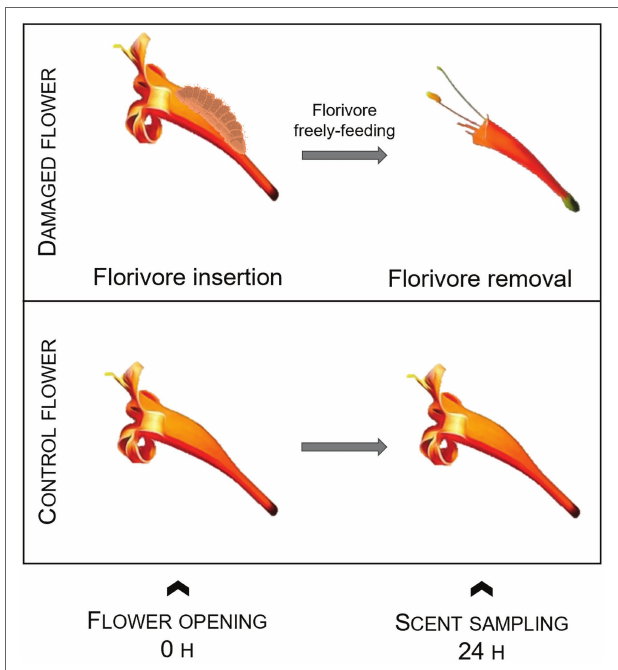
FIGURE 2 | Experimental design used to investigate short-term local changes in floral scent due to florivory by a lycaenid caterpillar. Caterpillar image from